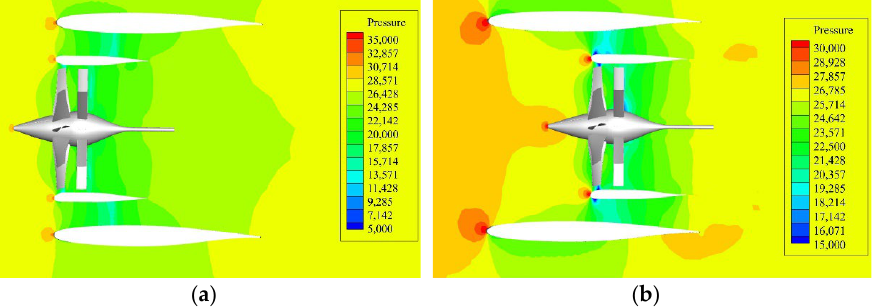
Figure 16. Pressure contours at different axial positions. ( a ) Contour at c = 0. ( b ) Contour at c = − 0.5